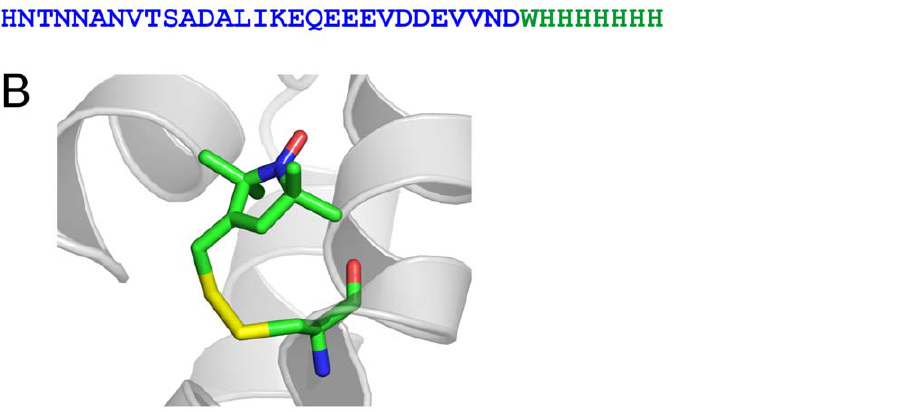
Figure 1. Spin labeling of Ure2p 1–89 -M. (A) Sequence of Ure2p prion domain construct with positions for spin labeling indicated by arrow heads. The amino acid sequences of Ure2p prion domain, Sup35p M domain, and other linker/tag regions are shown in black, blue, and green, respectively. (B) A stick model of spin label R1 in the crystal structure of spin-labeled T4 lysozyme (PDB entry 2IGC).